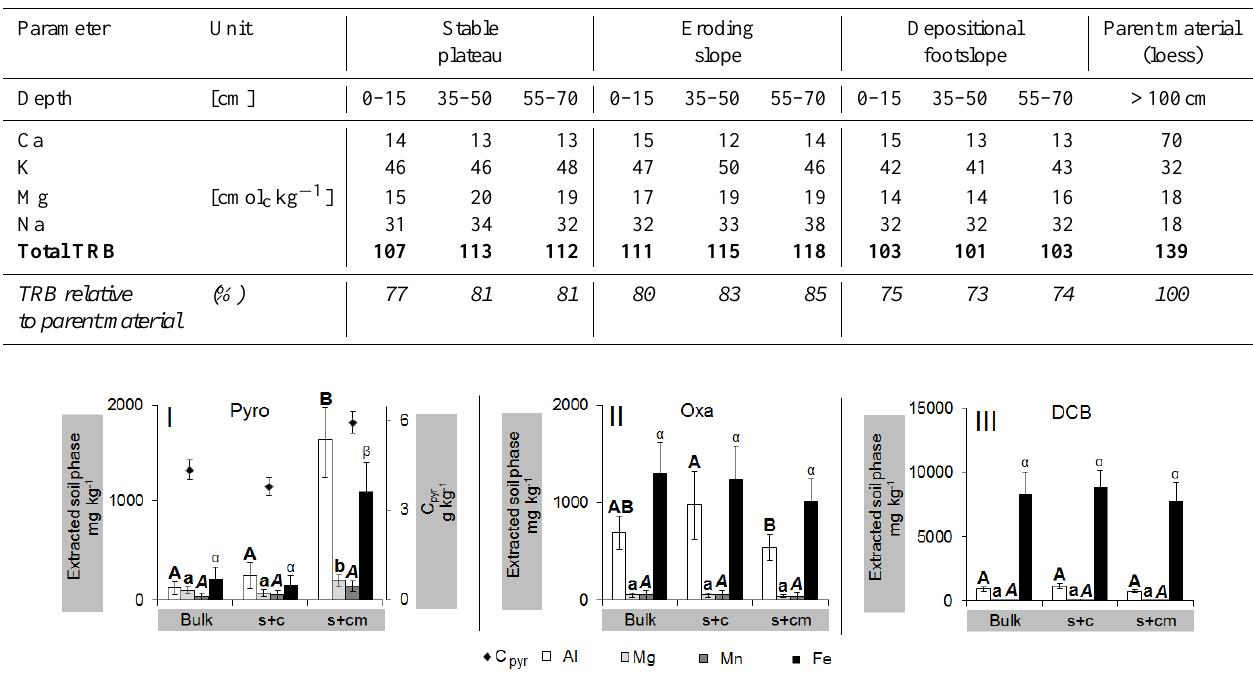
Figure 2. The distribution of pyrophosphate (I), oxalate (II) and dithionite (III) extractable Al, Mn and Fe between the bulk soil and its com- partments non-aggregated silt + clay (s + c) and aggregated silt + clay (s + cm) for all depths and positions combined (bars). Dots represent the the C extracted by pyrophosphate for the bulk soil and the fractions (Panel I only). Different letters above bars indicate a significant difference ( p <0.1, tested for extracted element in the different SOC fractions and treatments separately as indicated by differences in font